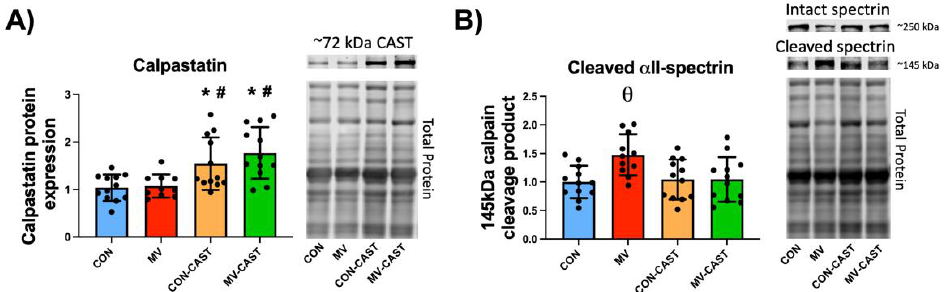
Figure 1. CAST overexpression prevents MV-induced activation of calpains. ( A ) Injection of AAV9- CAST into the diaphragm increase CAST expression in diaphragm fibers. ( B ) Overexpression of CAST in diaphragm fibers prevents MV-induced activation of calpains as determined by the calpain-specific cleavage fragment of αII -spectrin. * = significantly different from CON; # = significantly different from MV; θ = significantly different from CON, CON-CAST, and MV-CAST.